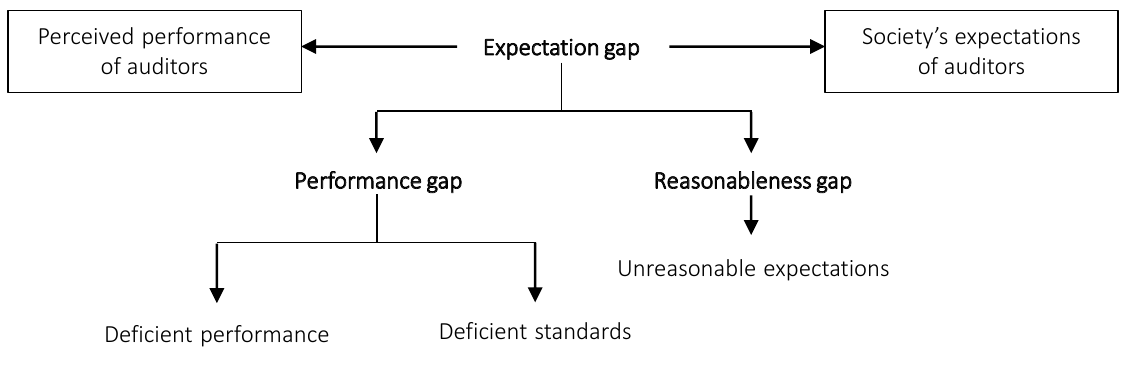
Figure 1. Structure of the expectation